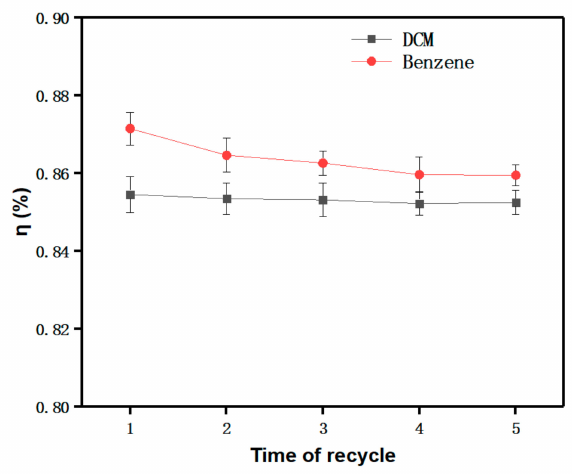
Figure 6. The absorptivity for DCM and benzene at different regeneration times (C DCM = 20,000 mg · m − 3 , C Benzene = 5000 mg · m − 3 , Q = 0.036 m 3 · h − 1 , T = 298.15 K, 60 wt%